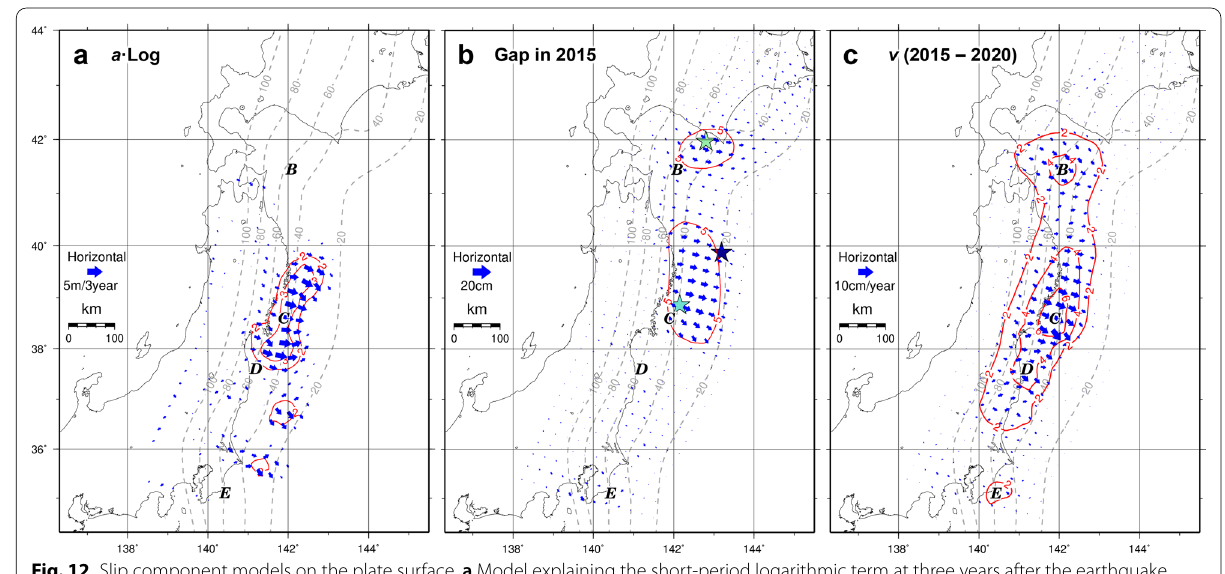
Fig. 12 Slip component models on the plate surface. a Model explaining the short-period logarithmic term at three years after the earthquake. Vectors indicate the motion of the upper plate with respect to the lower plate. b Model explaining gap 2015 . c Model explaining the linear deformation v from 2015; areas B to E represent the locations indicating the characteristic displacement in c . Isodepth contours of the Pacific slab were estimated by Kita et al. (2010), Nakajima and Hasegawa (2006), and Nakajima et al.